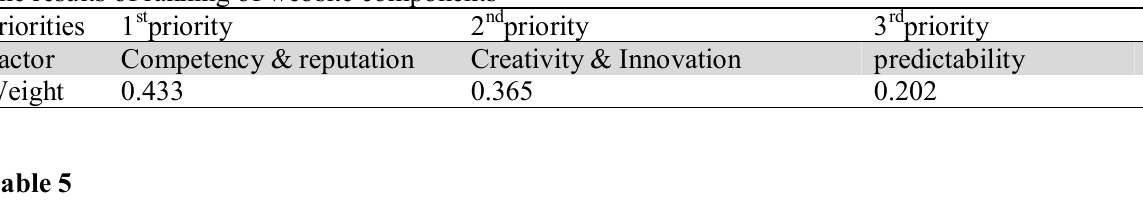
The results of aggregate factors Priorities